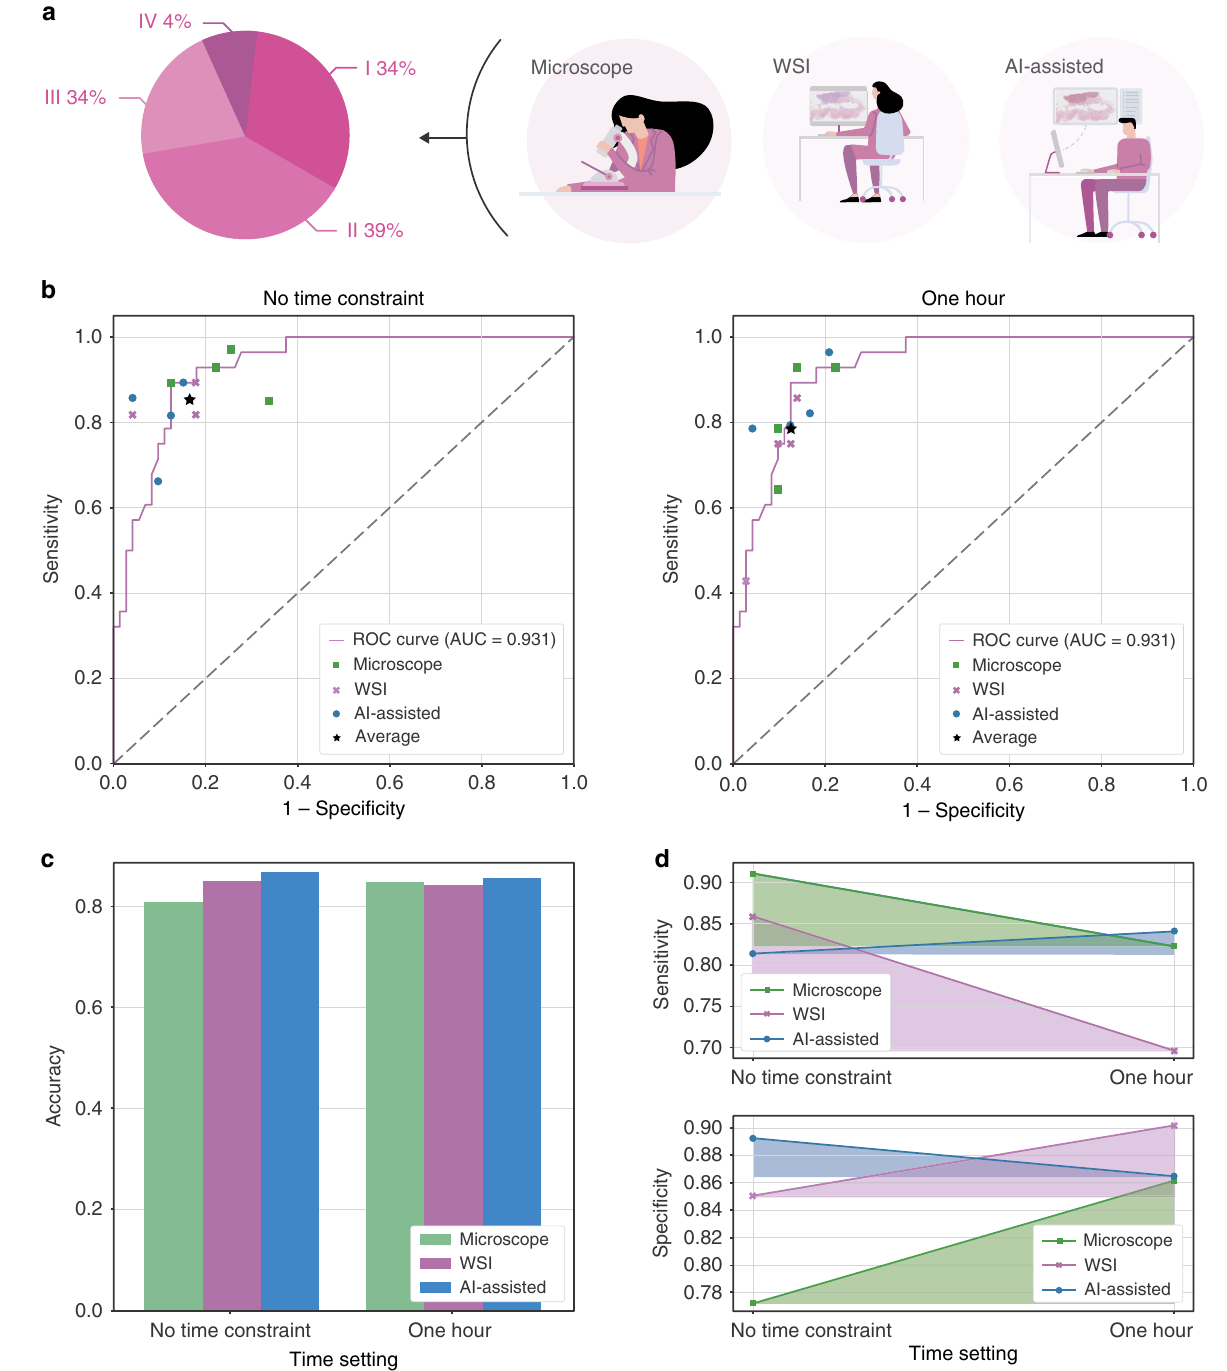
Fig. 3 Experimental settings and examination results of the performance of the pathology trainees. a Trainee pathologists were divided into 3 groups to make diagnoses on 100 slides of class I – VI. b The model prediction ROC curve and 12 pathologists' performance in the examination. c The average diagnostic accuracy of the three groups under different time settings. d Diagnostic consistency among different